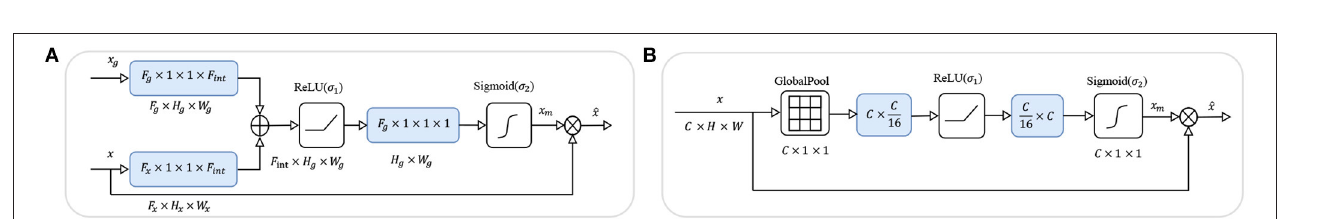
represents the element-wise sum, L